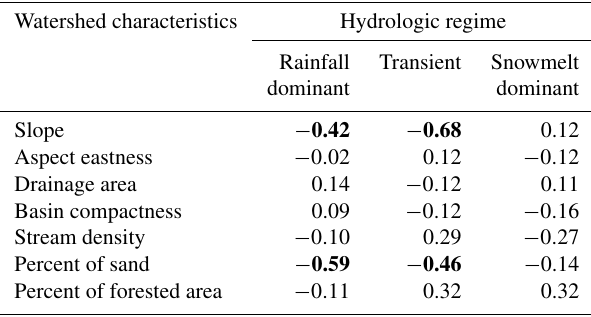
Table 5. Pearson correlation coefficient between KGE scores and selected basin physical characteristics. Bold values indicate that the relationship is significant at the 5% or 1%